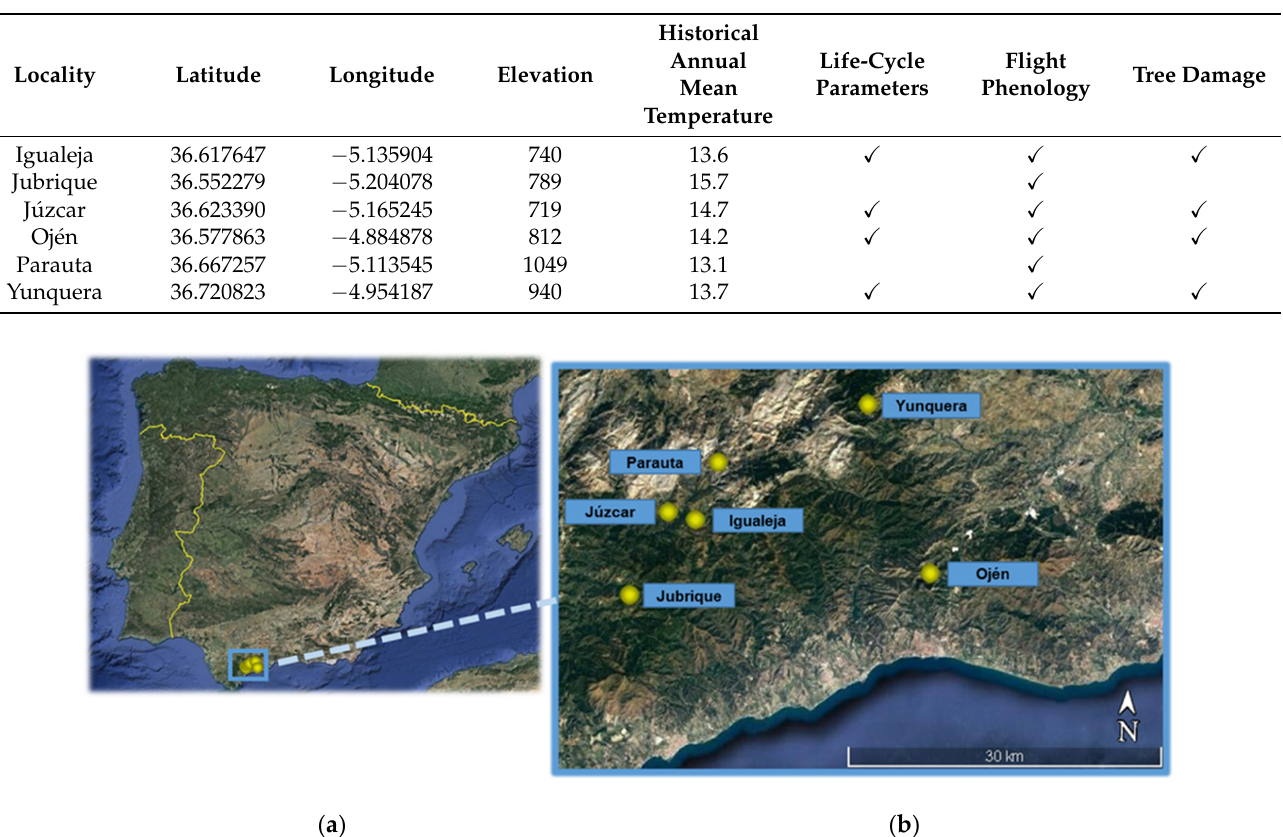
Table 1. Description of the six chestnut orchards sampled in Málaga, and the localities considered for each analysis. His- torical annual mean temperatures correspond to the 1971–2000 climate records. Elevation is expressed in m a.s.l. Historical annual mean temperature is expressed in °C.